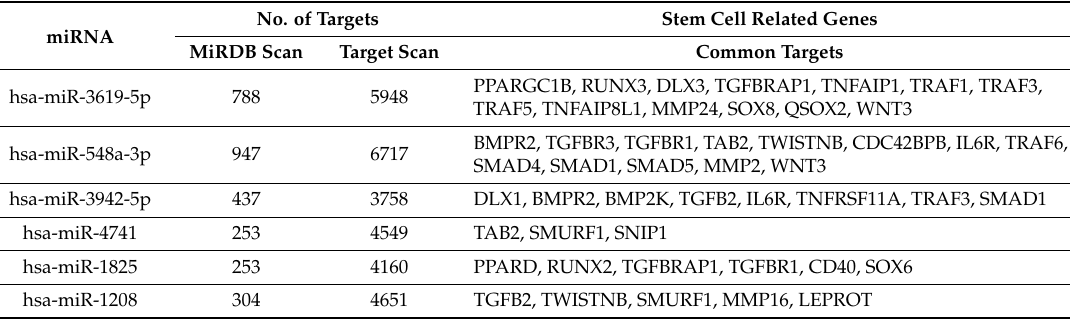
Table 4. Predicated targets of differentially regulated miRNAs of stem cell